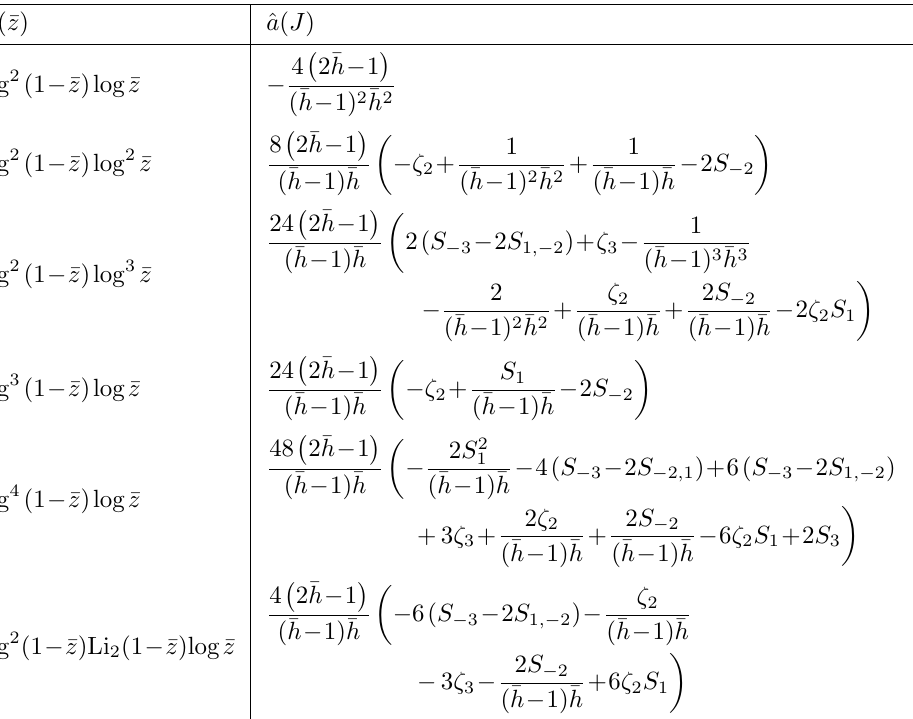
Table 2 . Inversions for G ((cid:22) z ) containing explicit powers of log (cid:22) z .